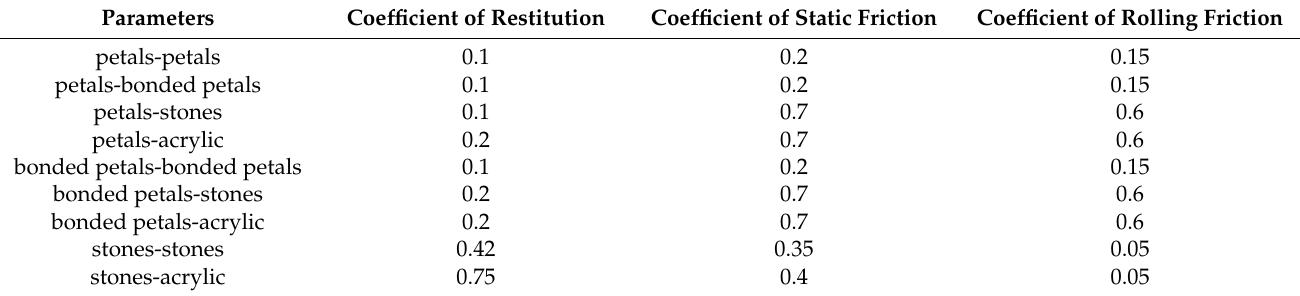
Table 2. Variance analysis of regression model.